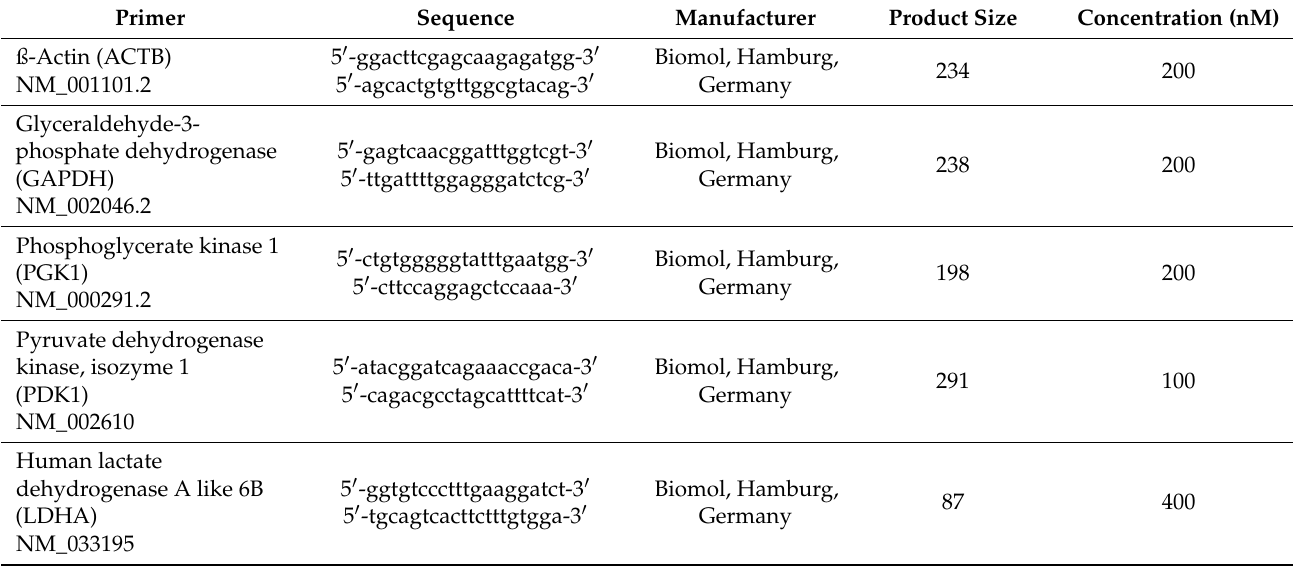
Table 2. Oligonucleotide primer sequences, product sizes, and primer concentrations for quantitative real-time